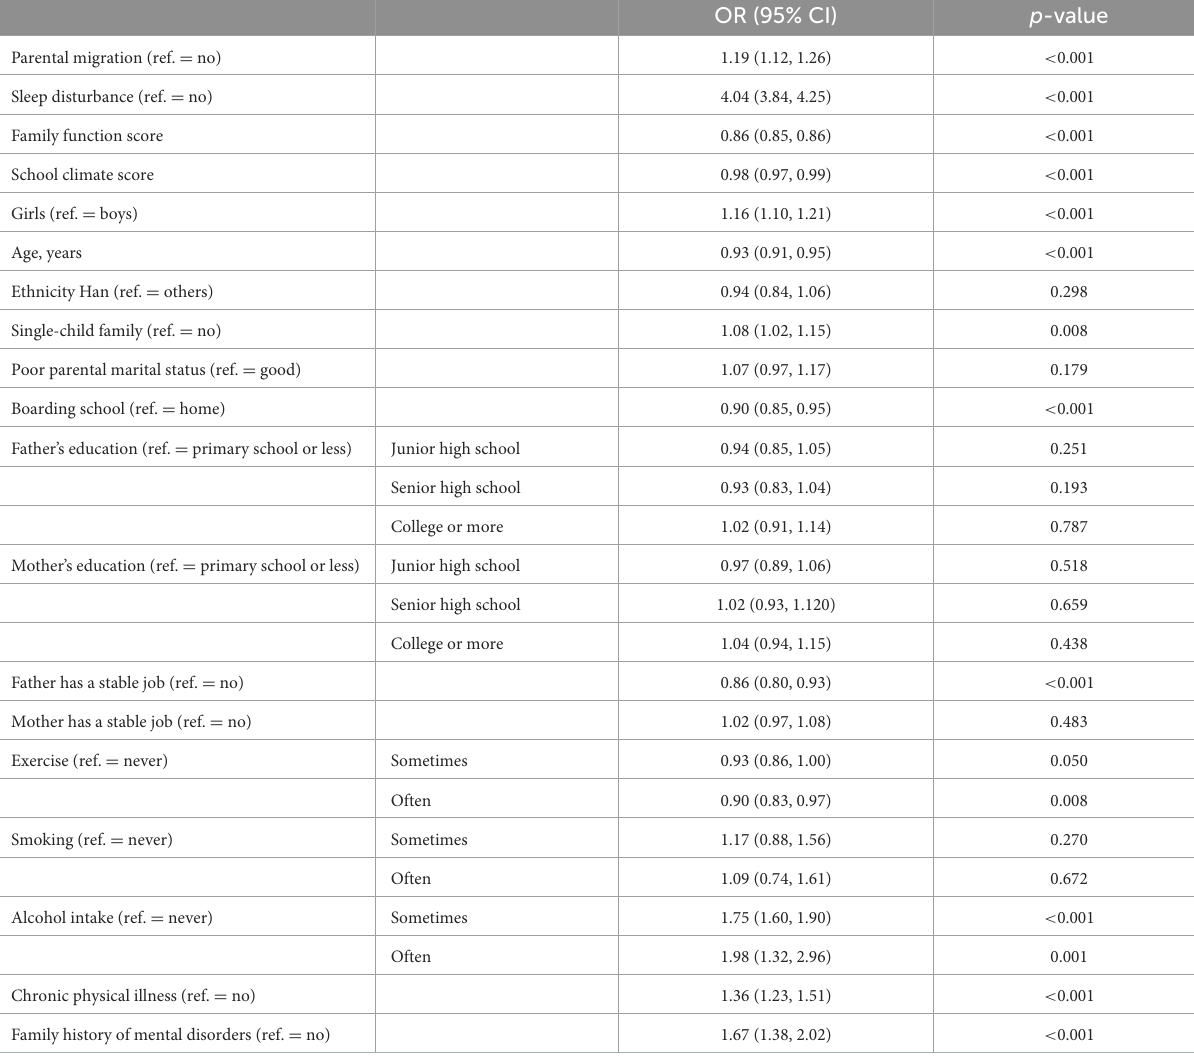
TABLE 3 Multinomial logistic regression of PLEs among